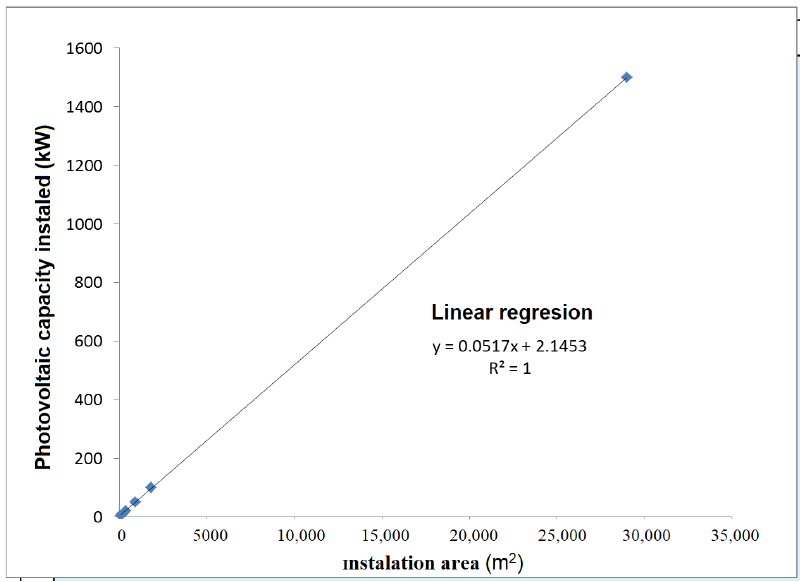
Figure 8. Photovoltaic